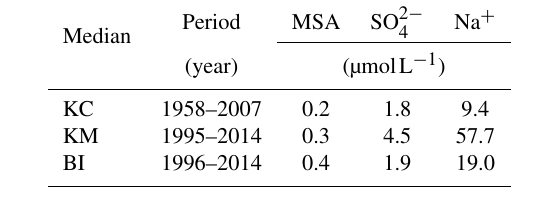
Table 2. Median ion concentrations (in µmolL − 1 ) in the KC, KM, and BI firn cores. Ion concentrations at the top 2m of the KC, KM, and BI cores were not measured. Non-detected concentrations were set to half the detection limit for each ion.